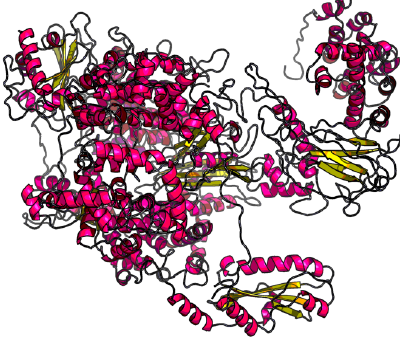
Figure 2. Tertiary structure obtained via RAPTORX for the entire 2092 amino acid sequence of the RVFV L protein. Rendering was performed with Visual Molecular Dynamics (VMD) software